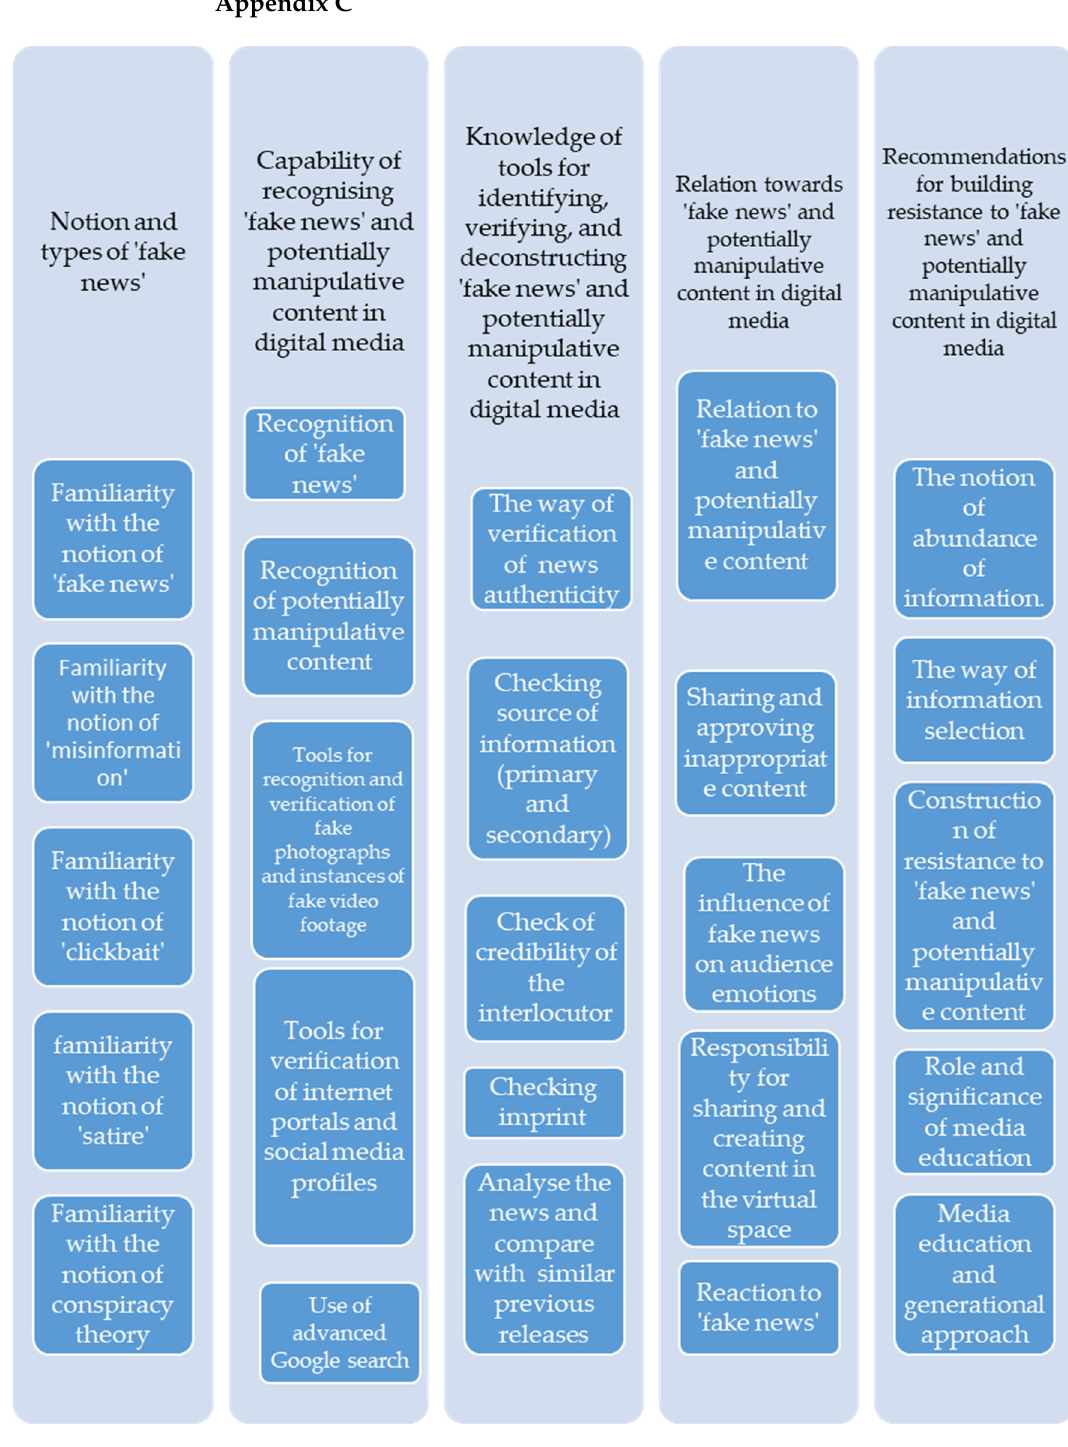
Figure A1. Pictorial representation of grouping codes into topics.